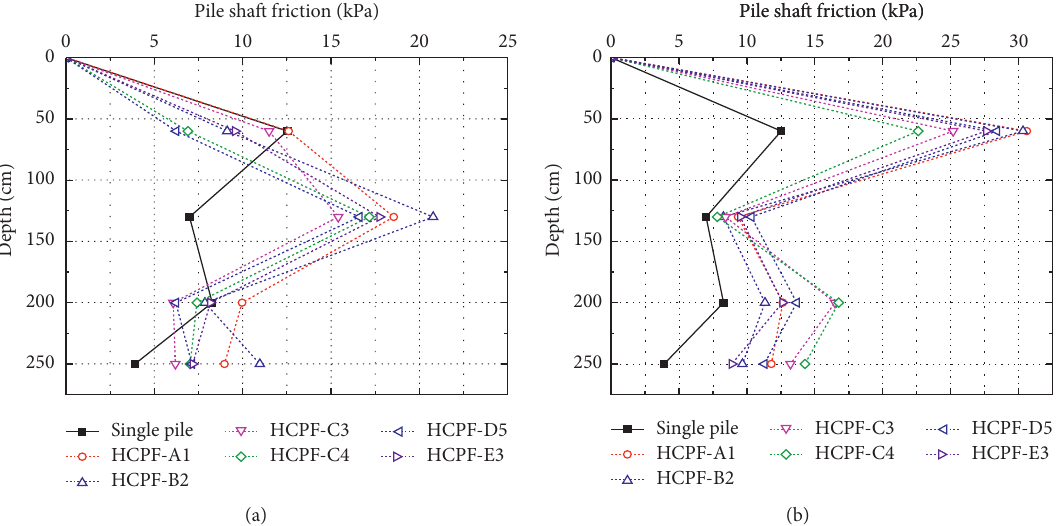
Figure 10: Pile shaft friction resistance of the foundation piles and the single pile under the ultimate bearing capacity. (a) HCPF piles and single pile. (b) LCPF piles and single